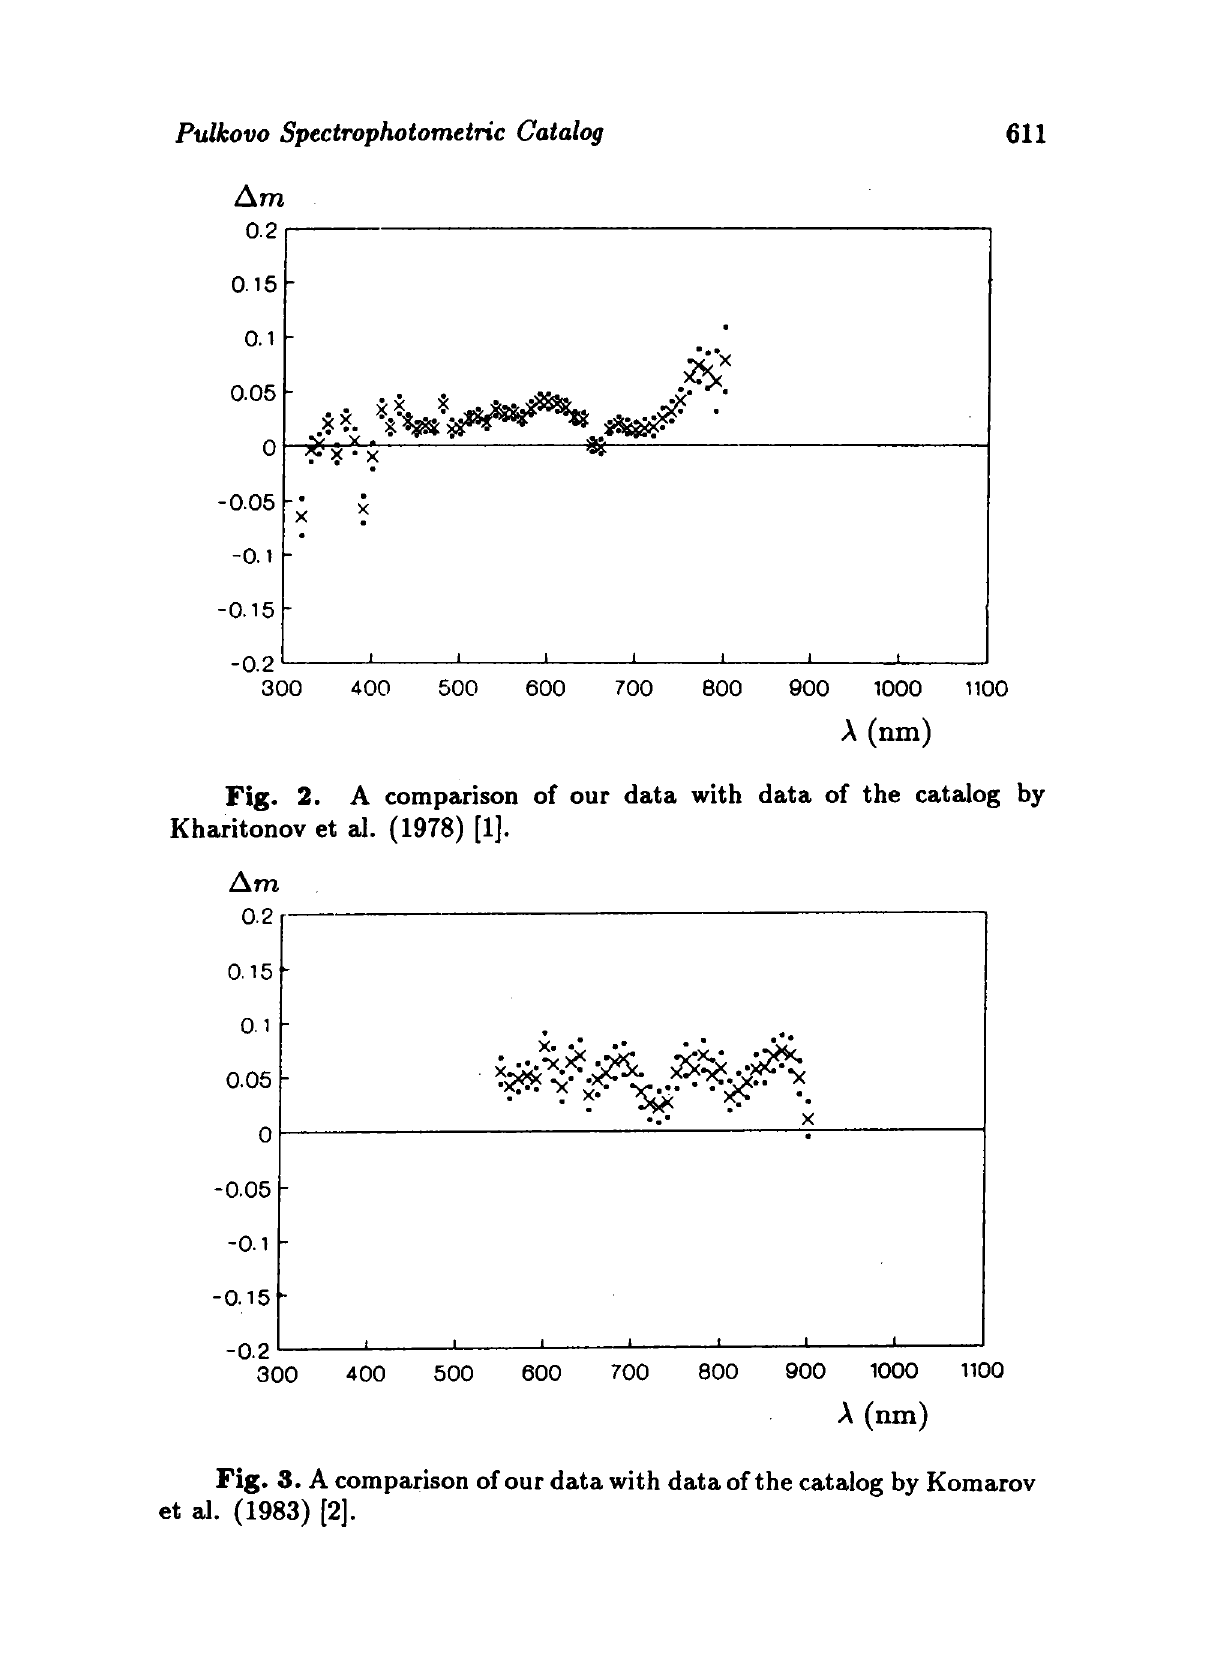
Fig. 3. A comparison of our data with data of the catalog by Komarov et al. (1983)